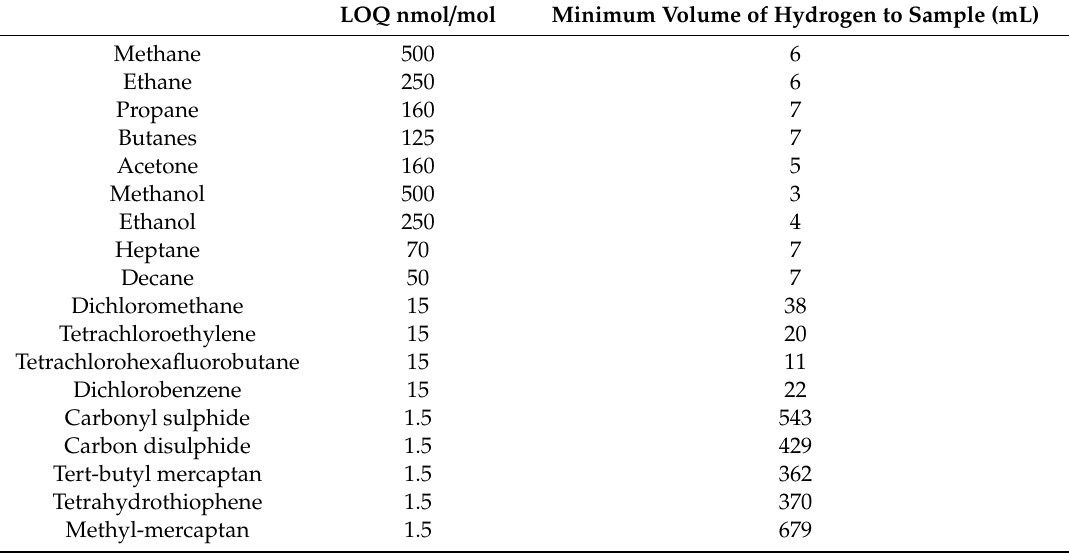
Table 5. Calculation of the minimum volume of hydrogen that should be sampled on sorbent tubes to reach the thresholds set in ISO 14687-2. LOQ nmol / mol Minimum Volume of Hydrogen to Sample (mL) 500